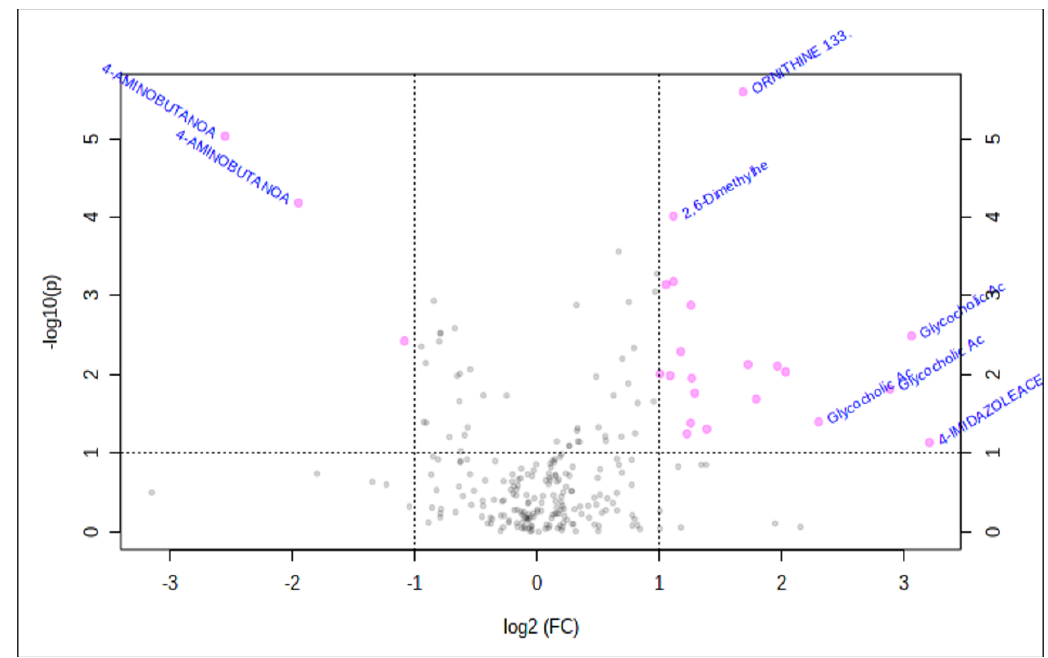
Figure 2. Volcano plot. Illustrates the scatter of metabolites with increased significance at the extremes of the plot.